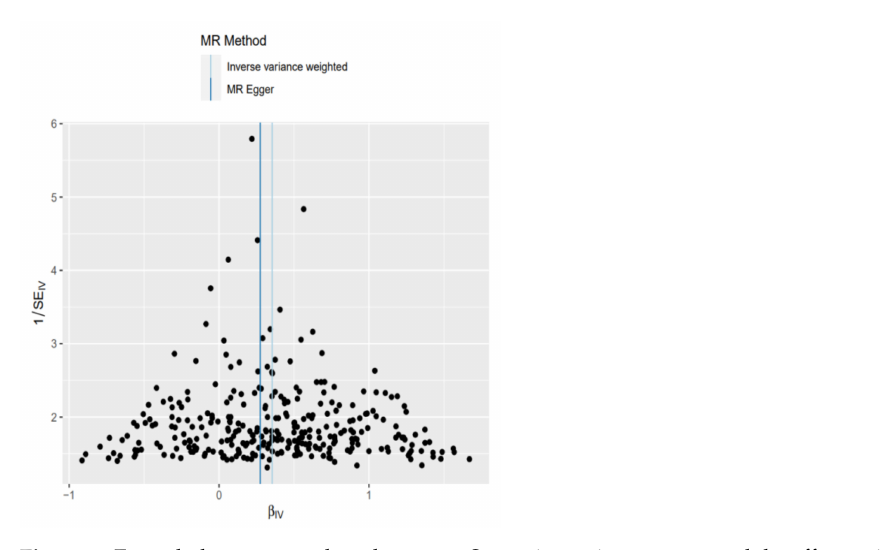
Figure 3. Funnel plot to assess the robustness. Scattering points represented the effect estimated using a single SNP as an instrumental variable. The vertical lines denoted the overall estimate obtained by the inverse variance weighted estimate and the MR-Egger